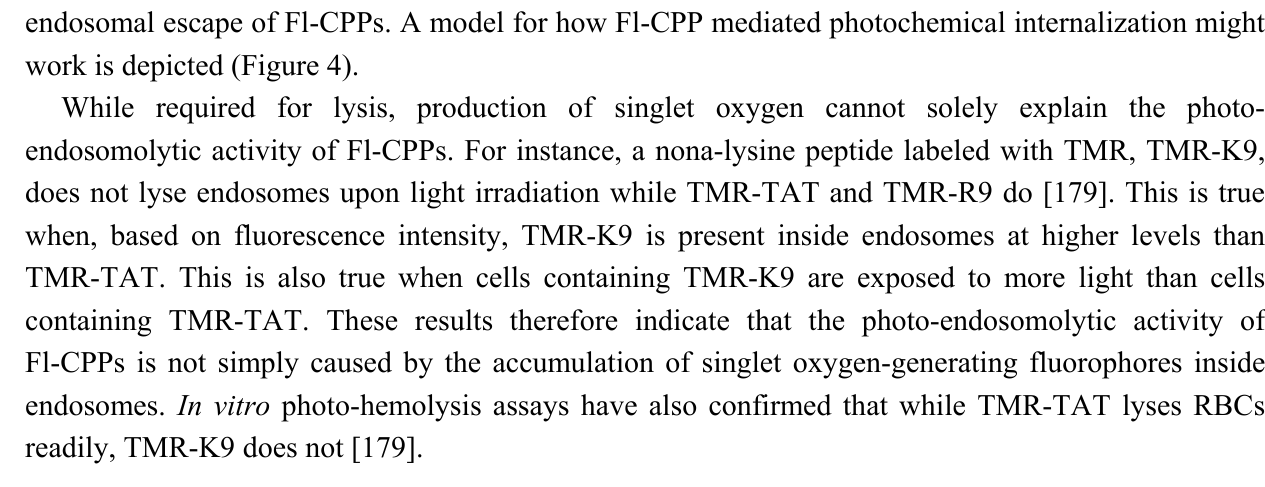
Figure 4. A model for fluorophore-CPP mediated PCI. The Fl-CPP conjugates exist in equilibrium in a membrane bound and unbound state due to the membrane-targeting role of the peptide moiety. Upon light irradiation, the fluorophore moiety of the conjugate produces singlet oxygen by transfer of energy from its triplet state to molecular